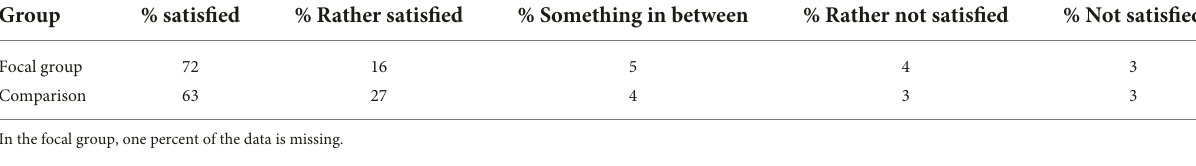
TABLE 4 Sum satisfaction with personal life in the focal group and comparison. Group % Satisfied % Rather satisfied % Something in between % Rather not satisfied % Not